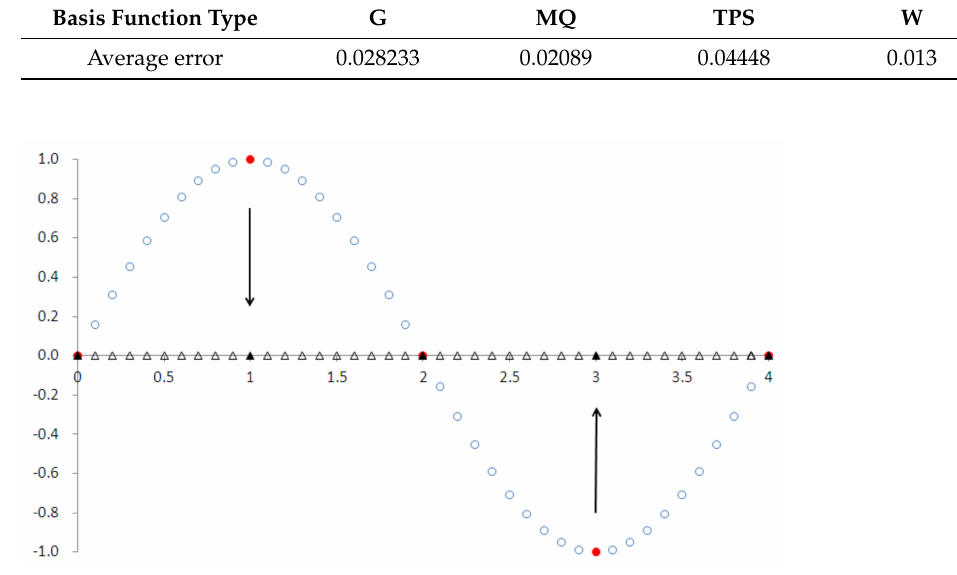
Figure 2. Sinusoidal function modification.